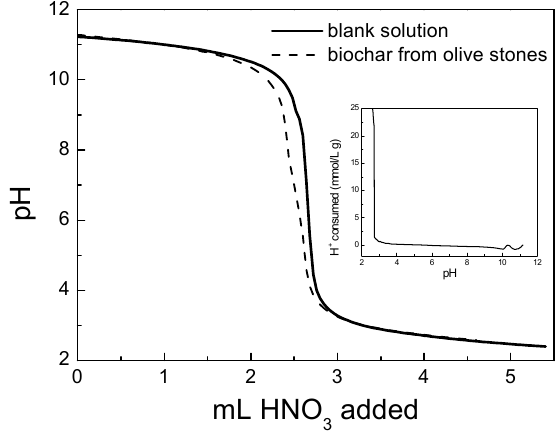
Figure 1. TGA curve obtained at a heating rate of 10 °C/min under 20 mL/min air flow. Inset: Differential TGA graph.